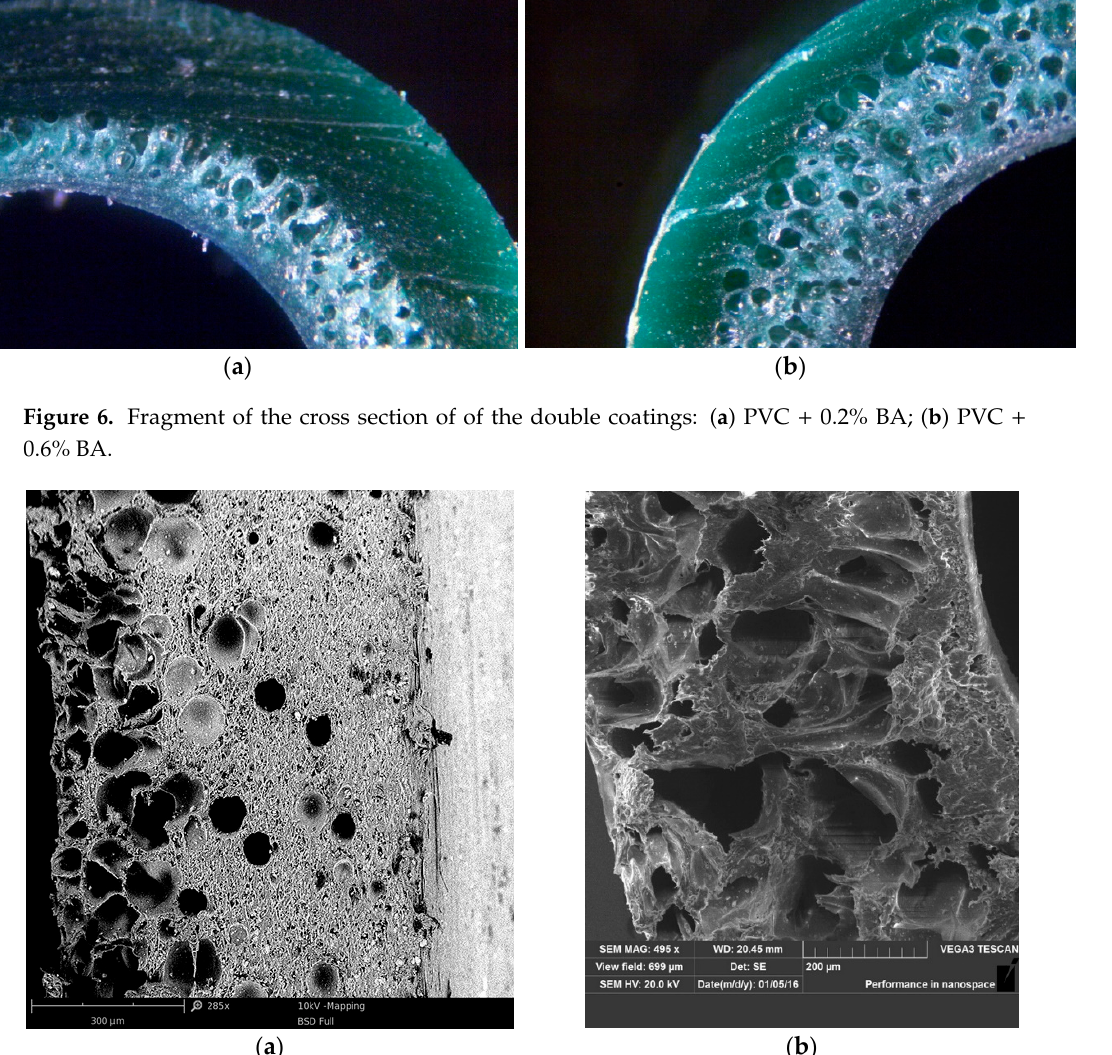
( b ) Figure 8. Scanning electron micrographs micrographs of the PVC double coatings: ( a ) PVC + 0.2% BA; ( b ) PVC + 0.6% BA. The pores of the largest size are in the center of the cellular layer, while the pores of the smaller size are in the layer near the surface, directly next to the solid layer of the produced coating (Figures 7 and 8). This is due to the speed and cooling efficiency of the cellular coating. Effective cooling prevents and reduces the growth of pores located directly at the surface of the coating. 4. Discussion The properties of cellular coating, taking into consideration criteria like porosity and density, should be assessed as very good. The obtained product has an outer coating with a degree of porosity from 19 to 40%, and density from 1155 to 800 kg/m 3 , depending on the amount of the BA in the modified materials.